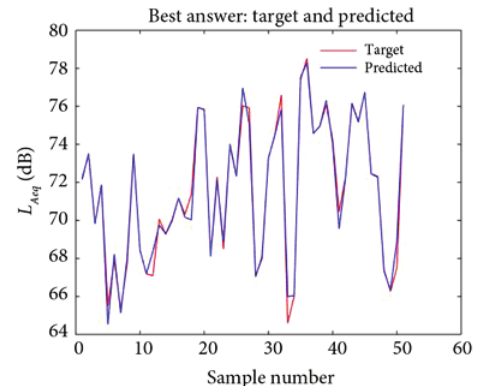
Figure 15. Comparing results of neural network model and field measurement